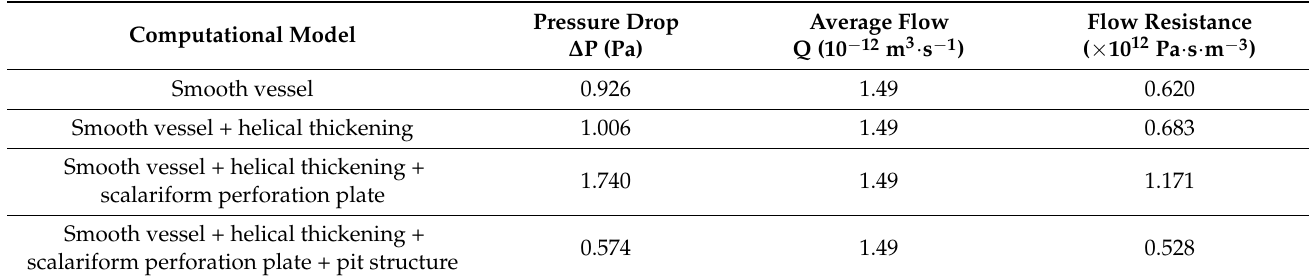
Table 2. Influence of the vessel structure on flow resistance.